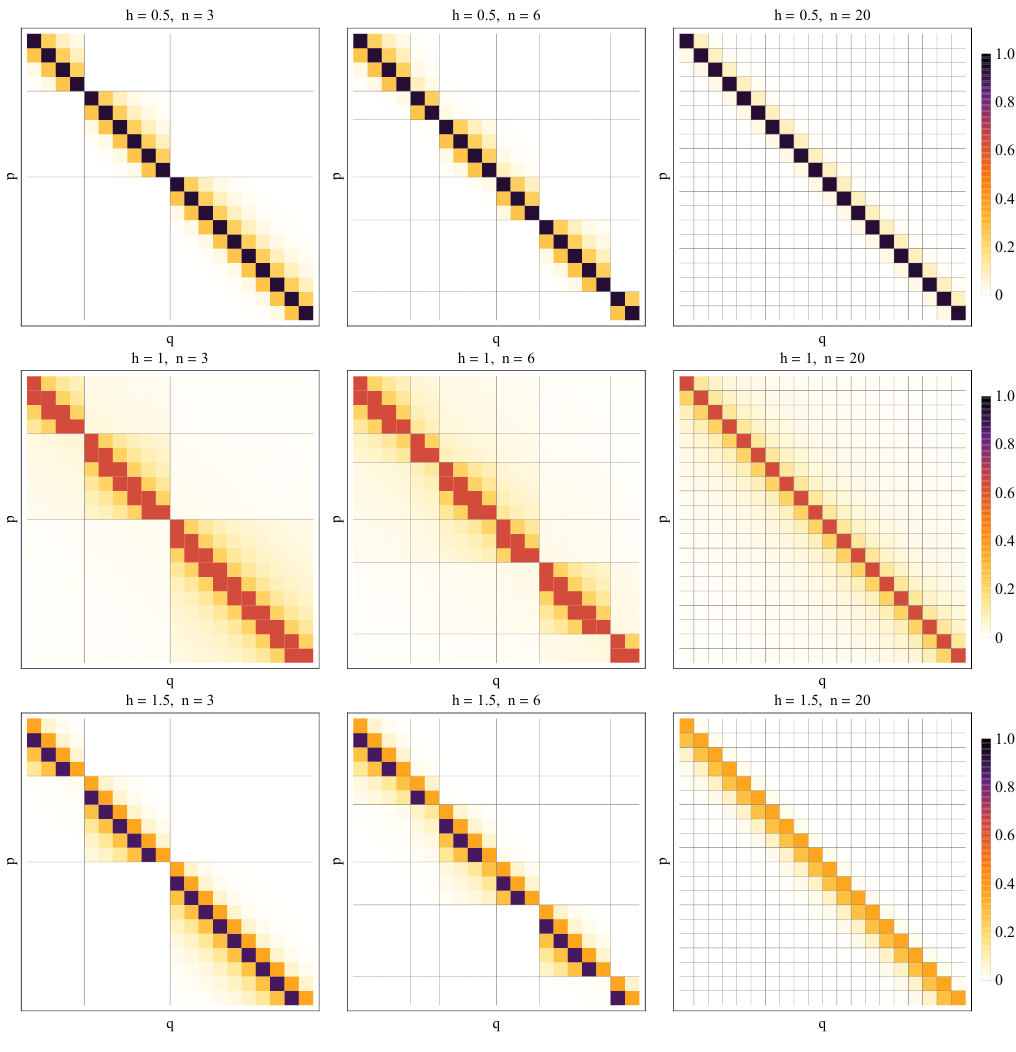
Figure 5: Matrix density plot of the absolute value of G different value of h and n . The straight grey lines define the sub-intervals [ j ] in order to highlight the block structure of the , j 2 i − 1 2 i